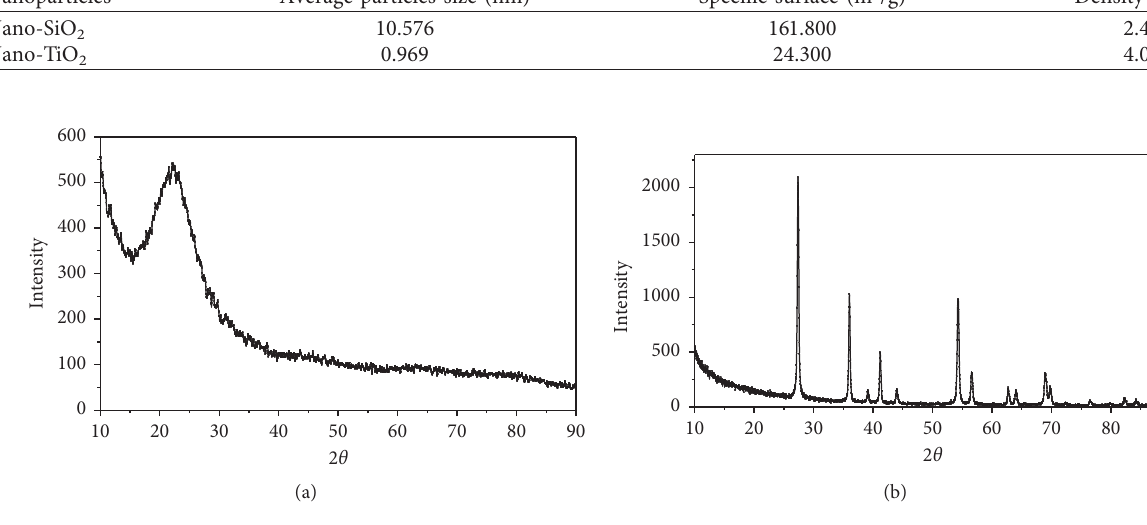
Figure 1: Diffractograms of (a) nano-SiO 2 and (b) nano-TiO 2 . Table 2: Physical properties of asphalt emulsion.